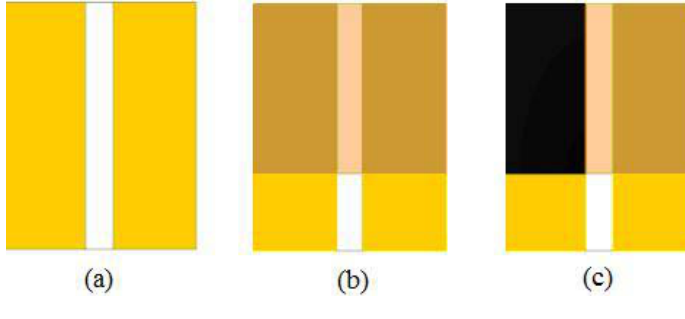
Figure 2. Schematic view of process steps for the realization of the sensors: ( a ) Linearly shaped gold electrodes applied onto the copier grade transparency sheets, developed by thermal evaporation in vacuum; ( b ) deposition of the ion conducting (Nafion:polypyrrole) film; ( c ) deposition of the conducting ink over the Nafion:polypyrrole film, in correspondence of one of the underlying gold